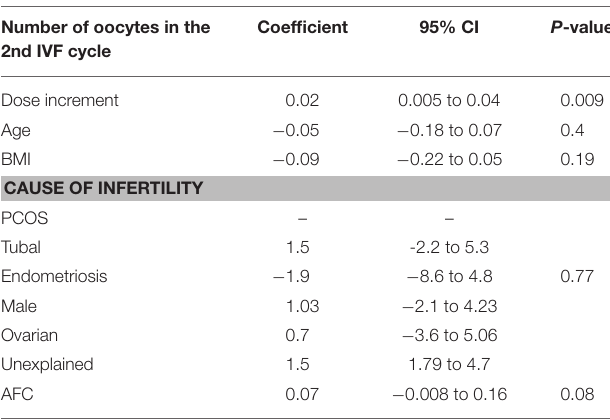
TABLE 3 | Generalized estimating equation (GEE) regression analysis for number of oocytes retrieved in the 2nd IVF cycle.